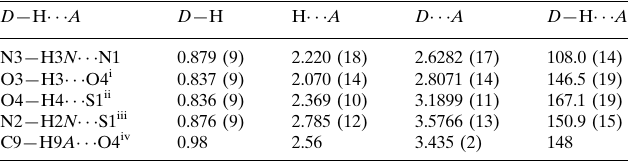
Hydrogen-bond geometry (A˚ , (cid:1)